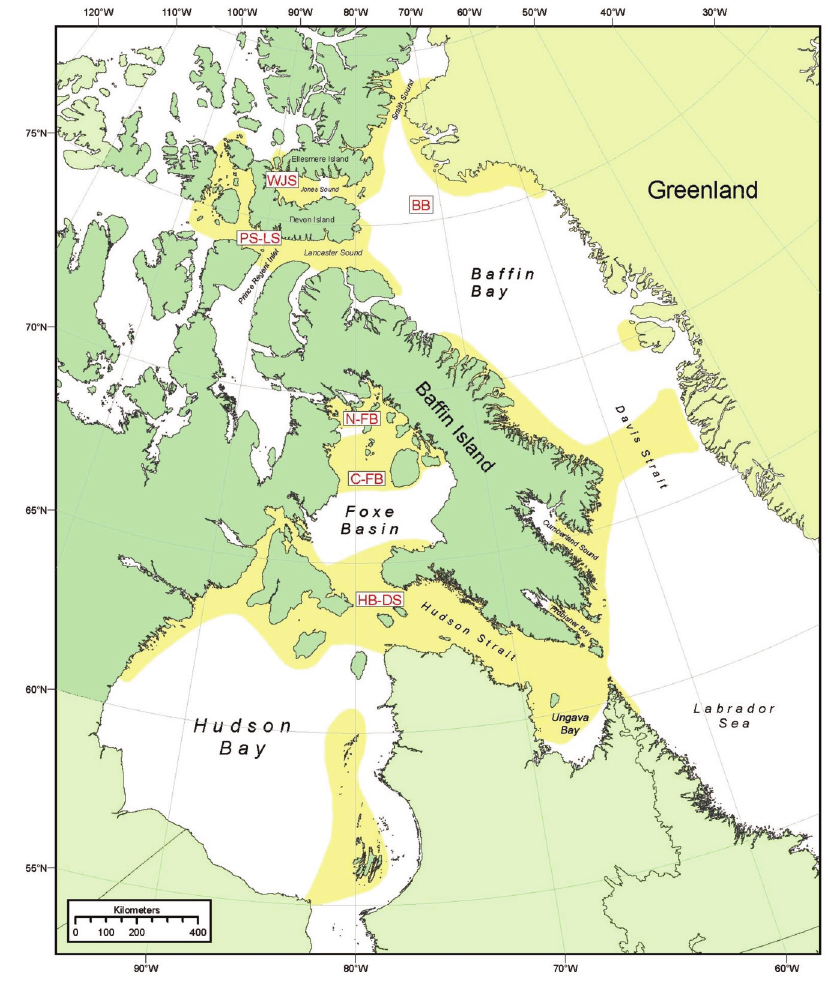
Fig. 1. Map of putative stocks for